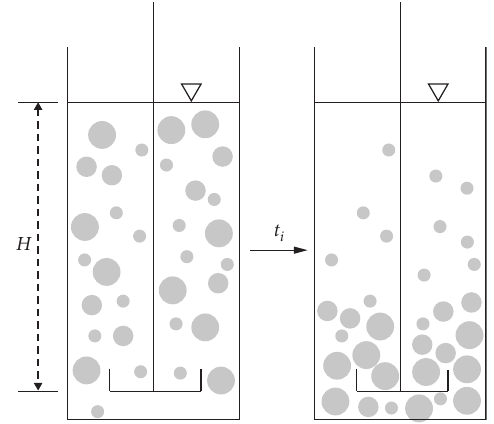
Figure 1: Schematic diagram of the settlement balance method.